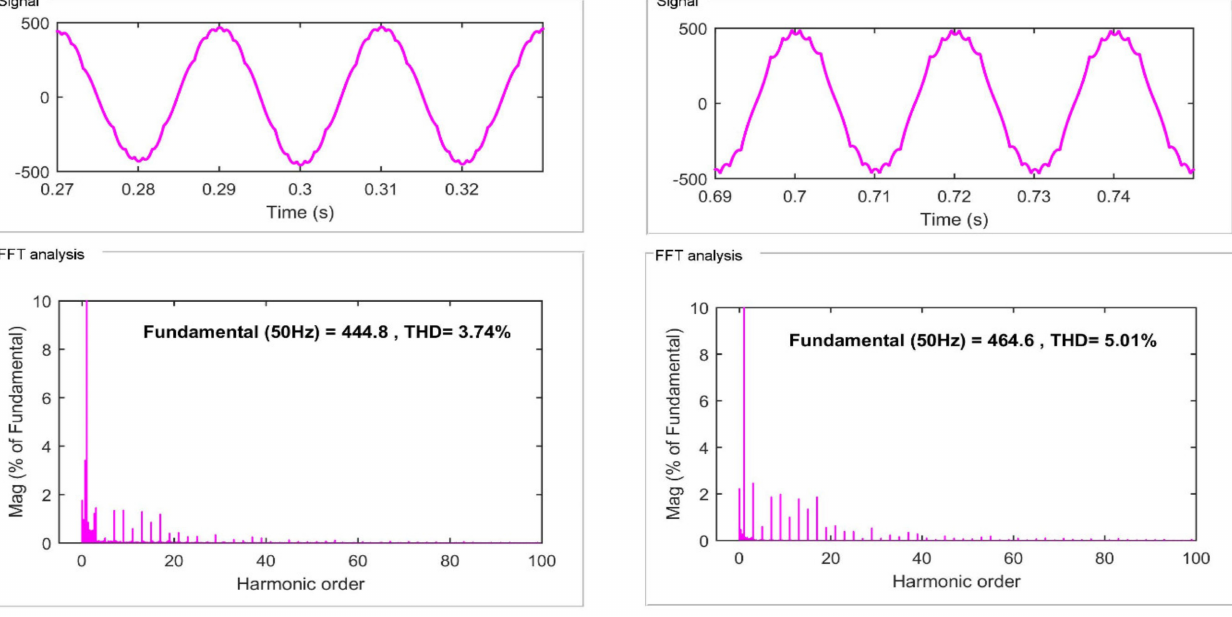
Figure 6. STATCOM currents’ harmonic spectra during cumulative loads of inductive and capacitive